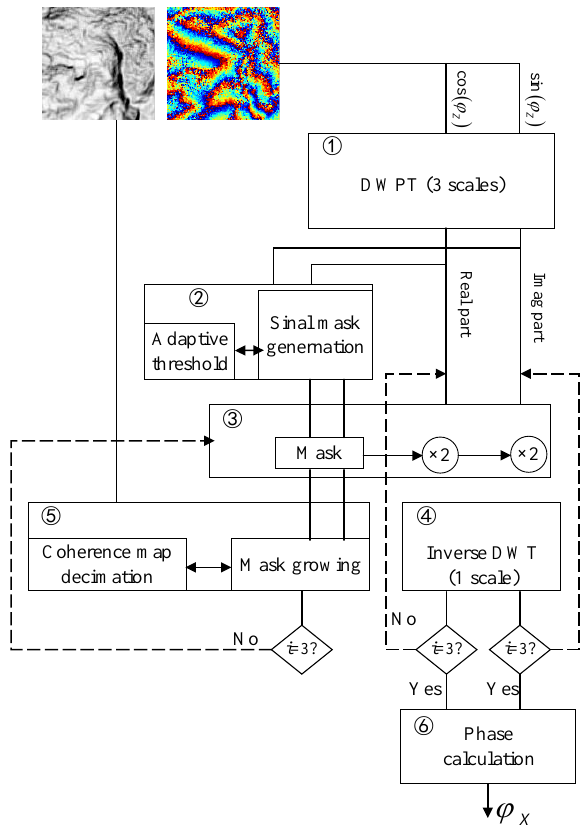
Figure 6. Multi-scale phase filtering process in the wavelet domain via six steps. DWPT: discrete wavelet package transform; DWT: discrete wavelet transform; Imag part: imaginary part; φ x : original phase; i : iteration times.